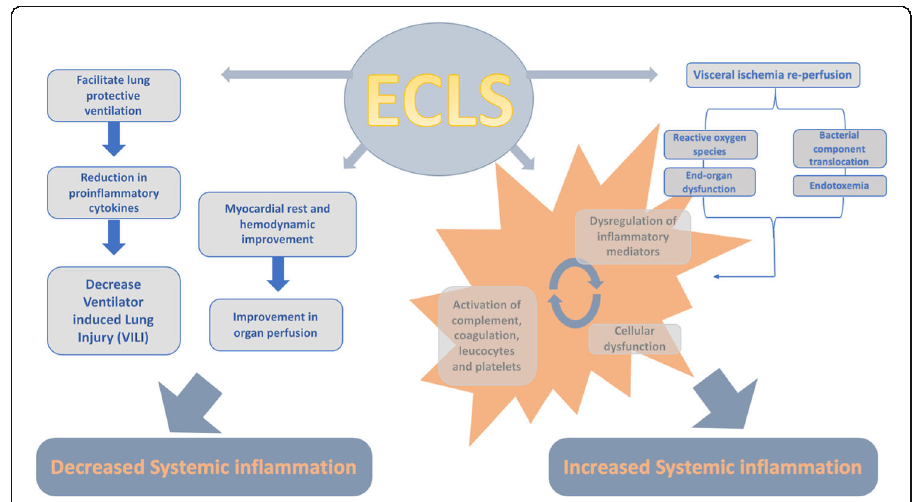
Fig. 1 Pathophysiology ECLS and associated inflammatory